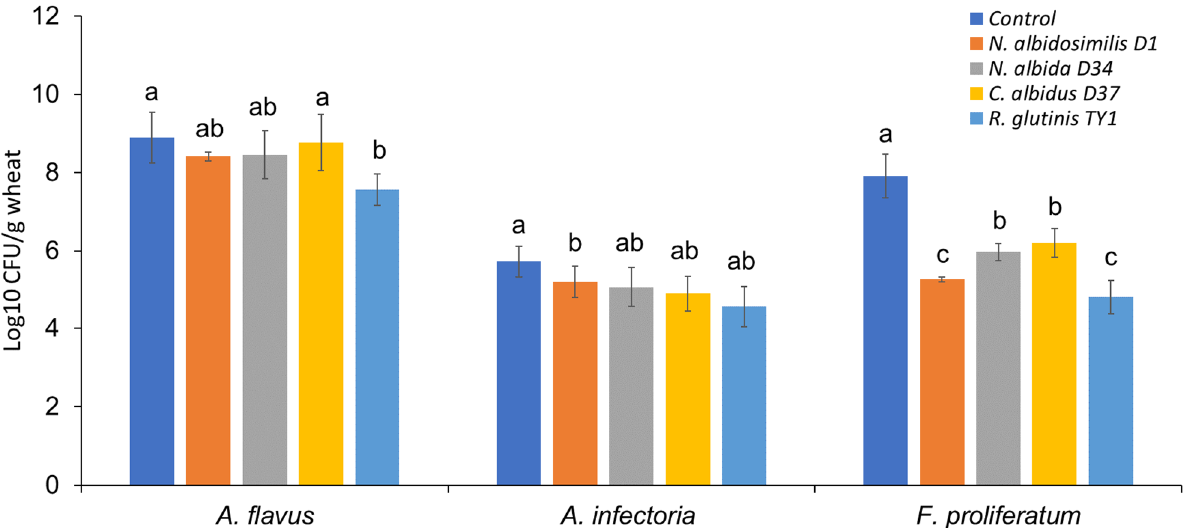
Figure 7. Antagonistic activity of four selected yeast isolates against three mycotoxigenic fungi in stored wheat grains. Error bars represent standard error of three independent biological replicates. Different letters above the error bars indicate statistically significant differences among treatments in each group at p < 0.05, as determined based on Duncan’s multiple range test.